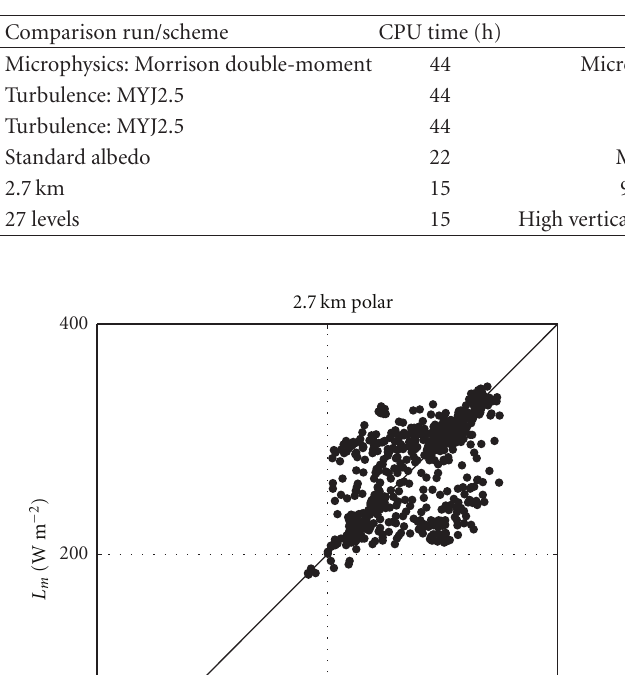
Table 8: Sensitivity runs with di ff erent physics, albedo, and resolution.